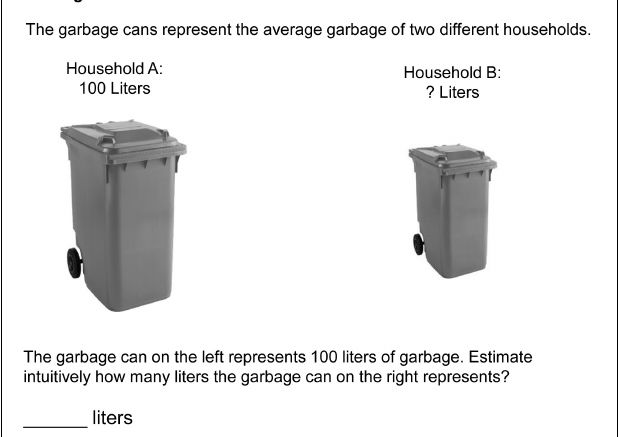
FIGURE 3 | Item of the Garbage test translated into English: The garbage can on the left is scaled by the factor